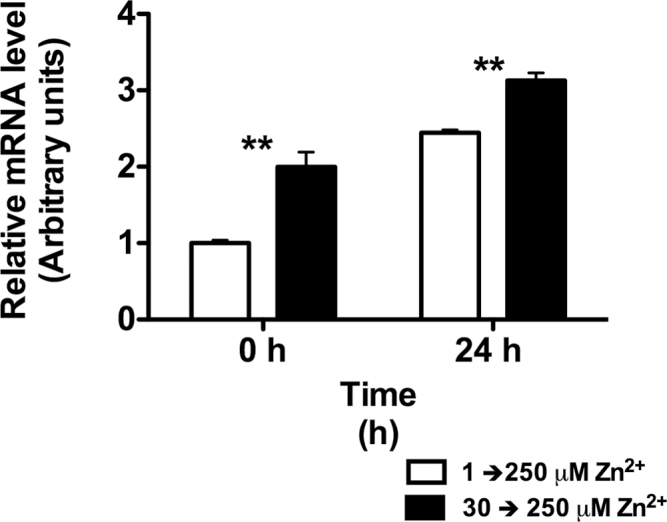
Relative transcript levels of the tobacco orthologue of the A. thaliana MTP1 gene (NtMTP1) before (prior to the addition of Zn2+) and 24h after the addition of 250 μM ZnSO4 in the root zone. In two treatments, the plant root systems were exposed increasing Zn2+ concentrations (1, considered as the control treatment, and 250 μM ZnSO4). In the remaining treatment, 1 week prior to the treatment (250 μM ZnSO4), plants were exposed to 30 μM ZnSO4. Values are means±SE (n=4). The mRNA levels of genes for NtMTP1 were determined by real-time PCR using specific primer pairs and normalized to that of the EF 1-α. Asterisks indicate significant differences between acclimated and non-acclimated treatment. **P<0.01.